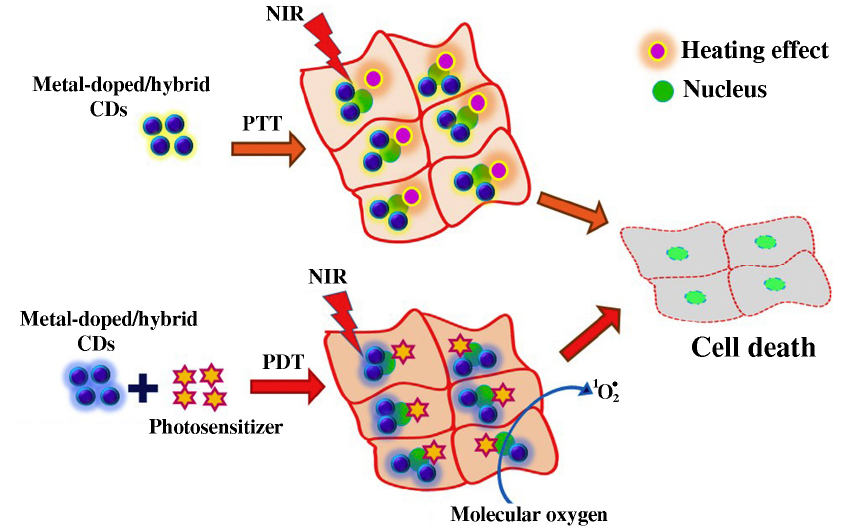
Figure 7. Photodynamic and photothermal therapy induced by metal-doped/hybrid CDs. Reprinted from Journal of Controlled Release , 330, Neeraj Tejwan, Adesh K. Saini, Anirudh Sharma, Th. Abhishek Singh, Nitin Kumar, and Joydeep Das, Metal-doped and hybrid carbon dots: A comprehensive review